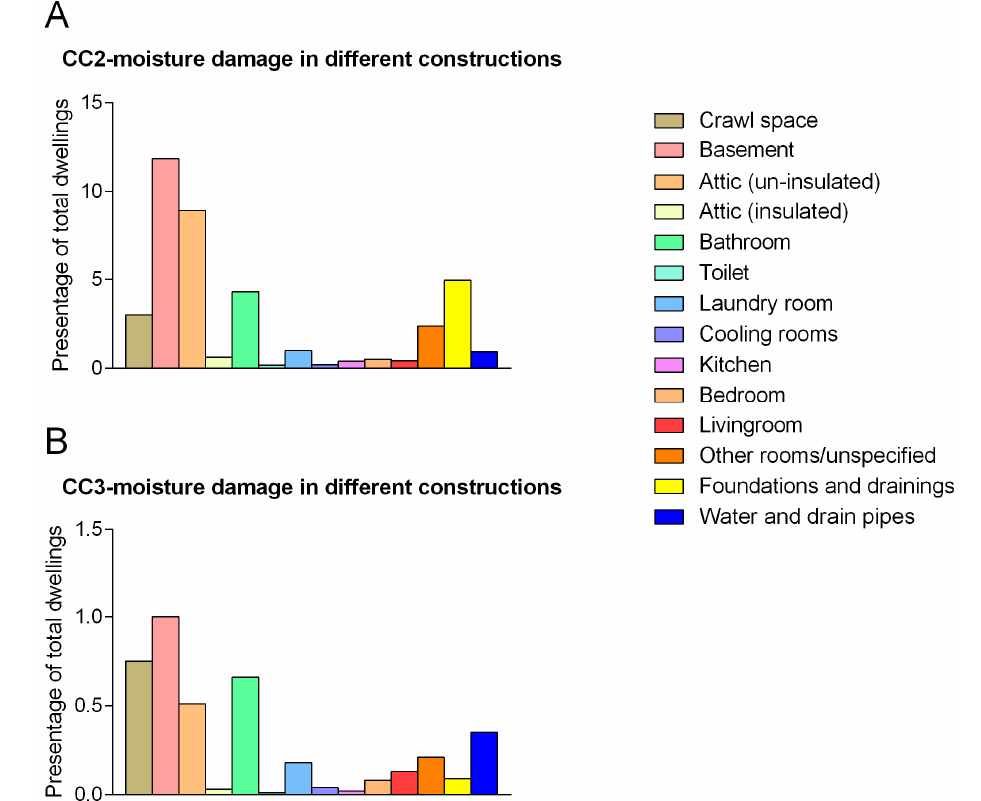
Figure 5. Grade of moisture damage distributed by construction/room type. The figure shows percentage of Norwegian dwellings with CC2 ( A ) and CC3 ( B ) moisture damage in the various rooms.